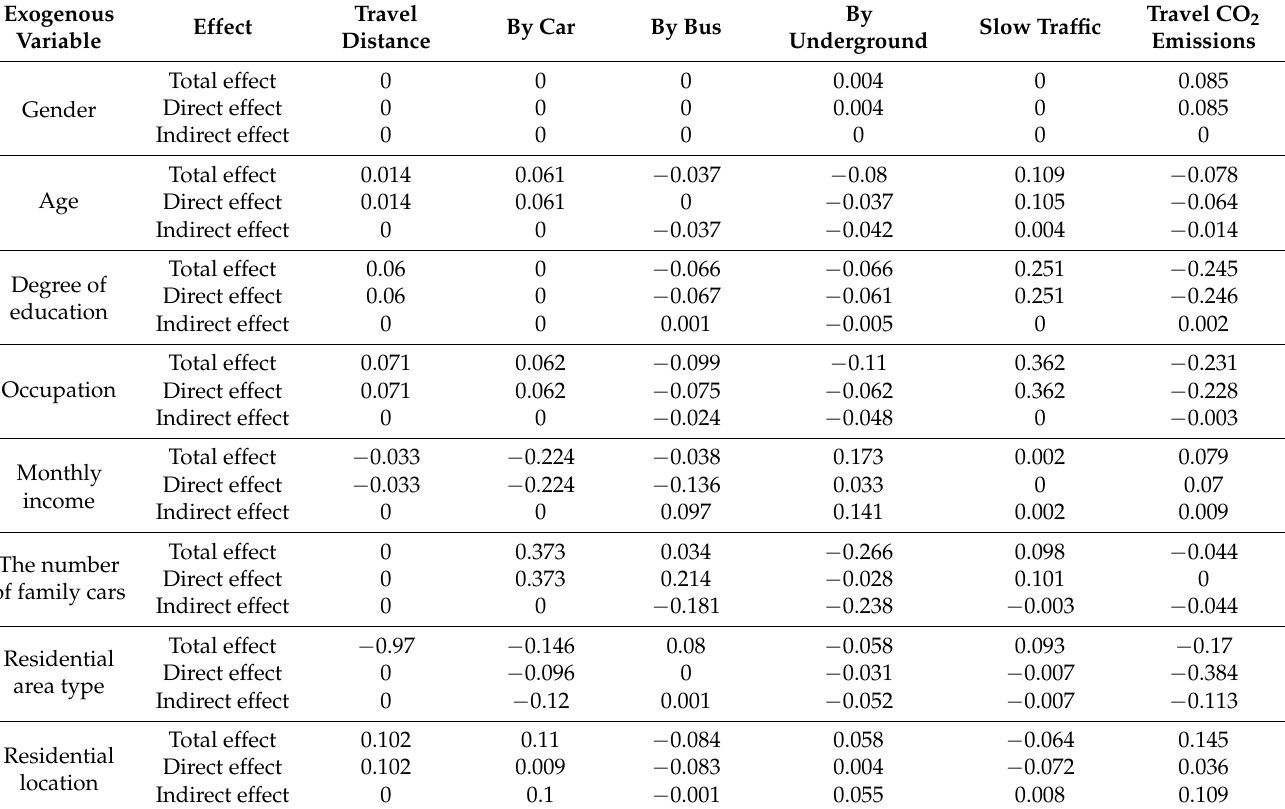
Table 6. Total, direct, and indirect effects of exogenous variables on endogenous